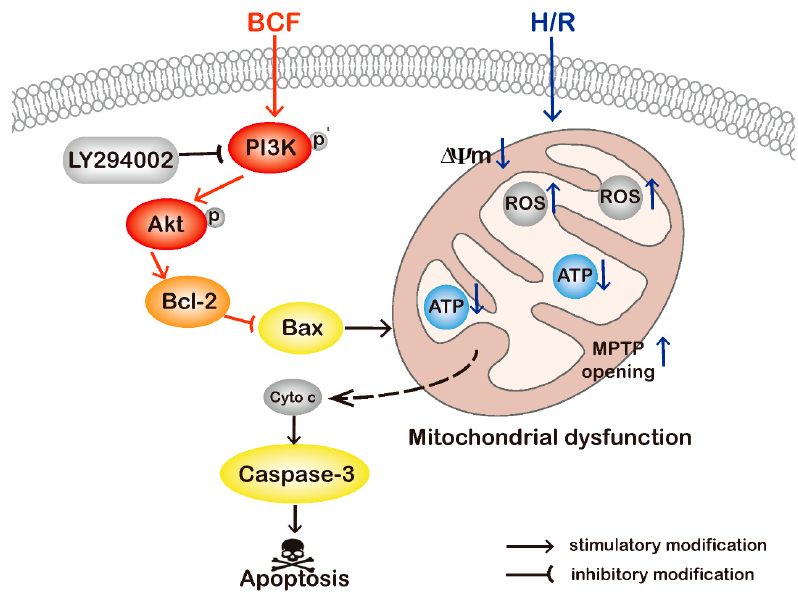
Figure 6. Schematic diagram of the mechanism of BCF alleviates H/R induced apoptosis in H9c2 cells by improving mitochondrial dysfunction through activating the PI3K/Akt pathway.